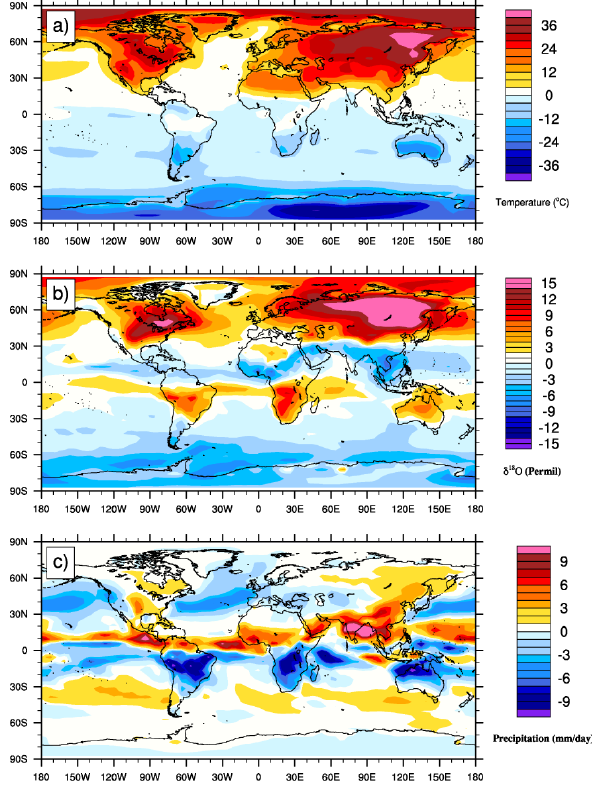
Fig. 7. The JJA–DJF difference of (a) surface temperature ( ◦ C), (b) δ 18 O precip (‰), and (c) total precipitation (mmday − 1 ) of the control experiment.